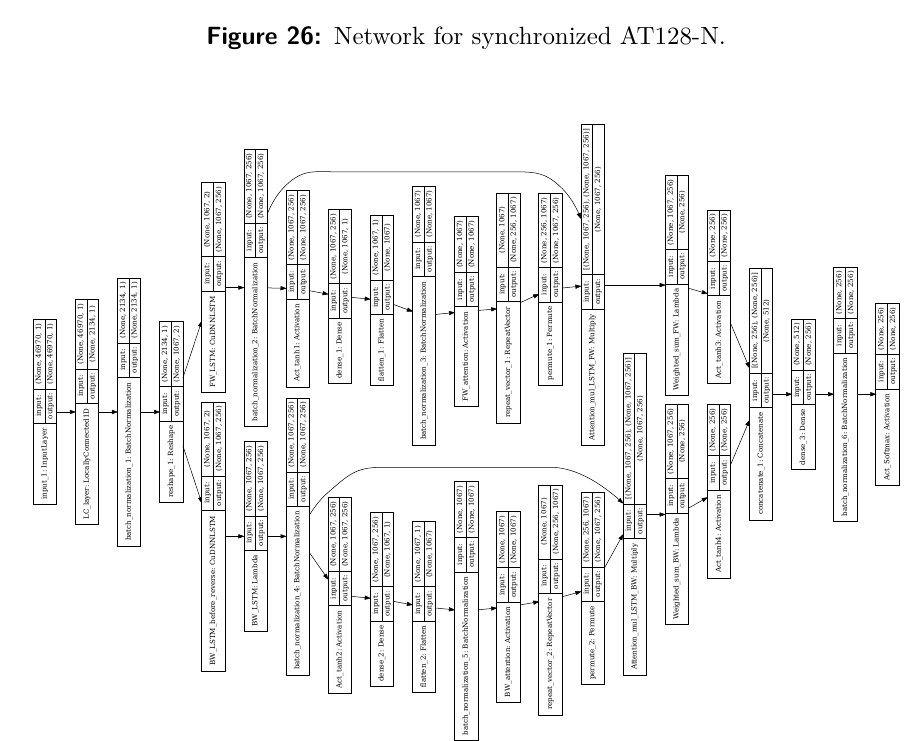
Figure 27: Network for synchronized